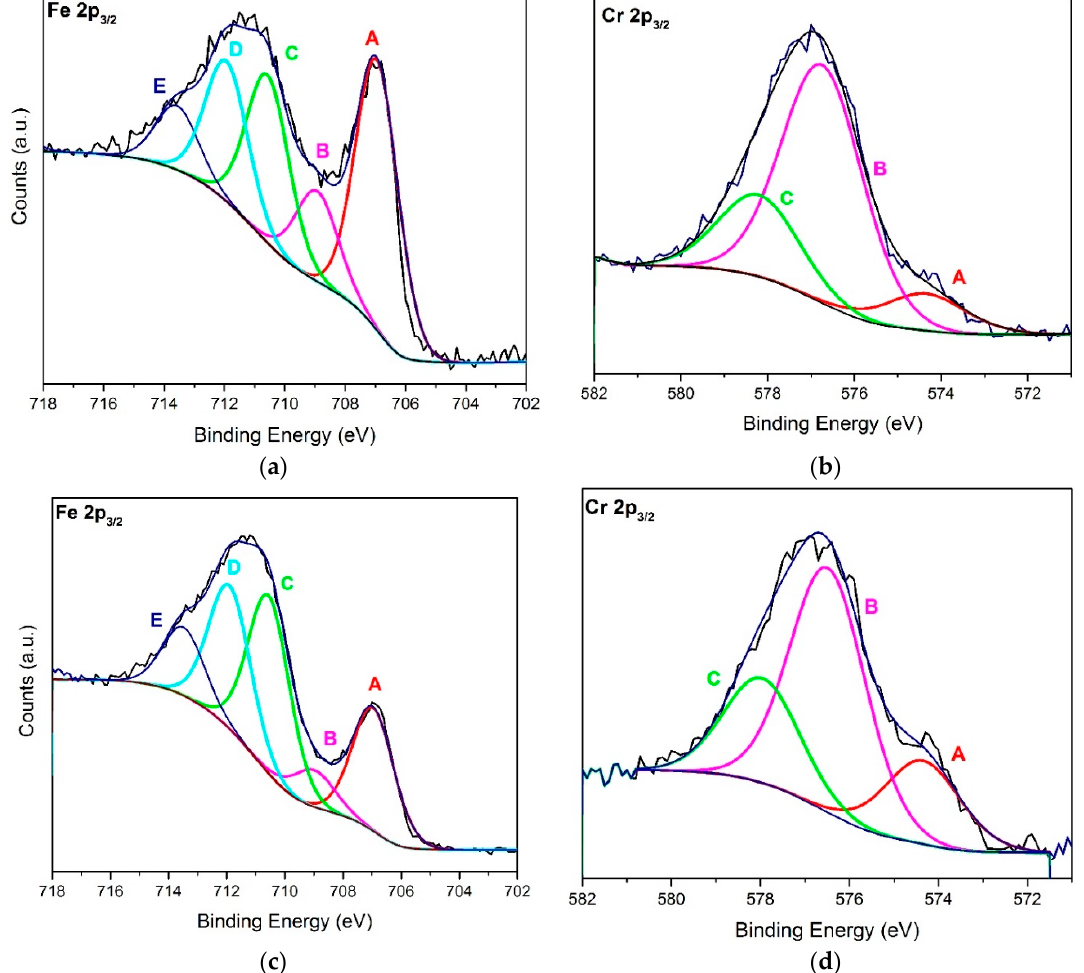
Figure 7. Peak fitting of Fe 2p 3/2 and Cr 2p 3/2 spectra of as-quenched samples broken in brittle ( − 100 °C) field ( a ) and ( b ) and ductile (+150 °C) field ( c ) and ( d ).